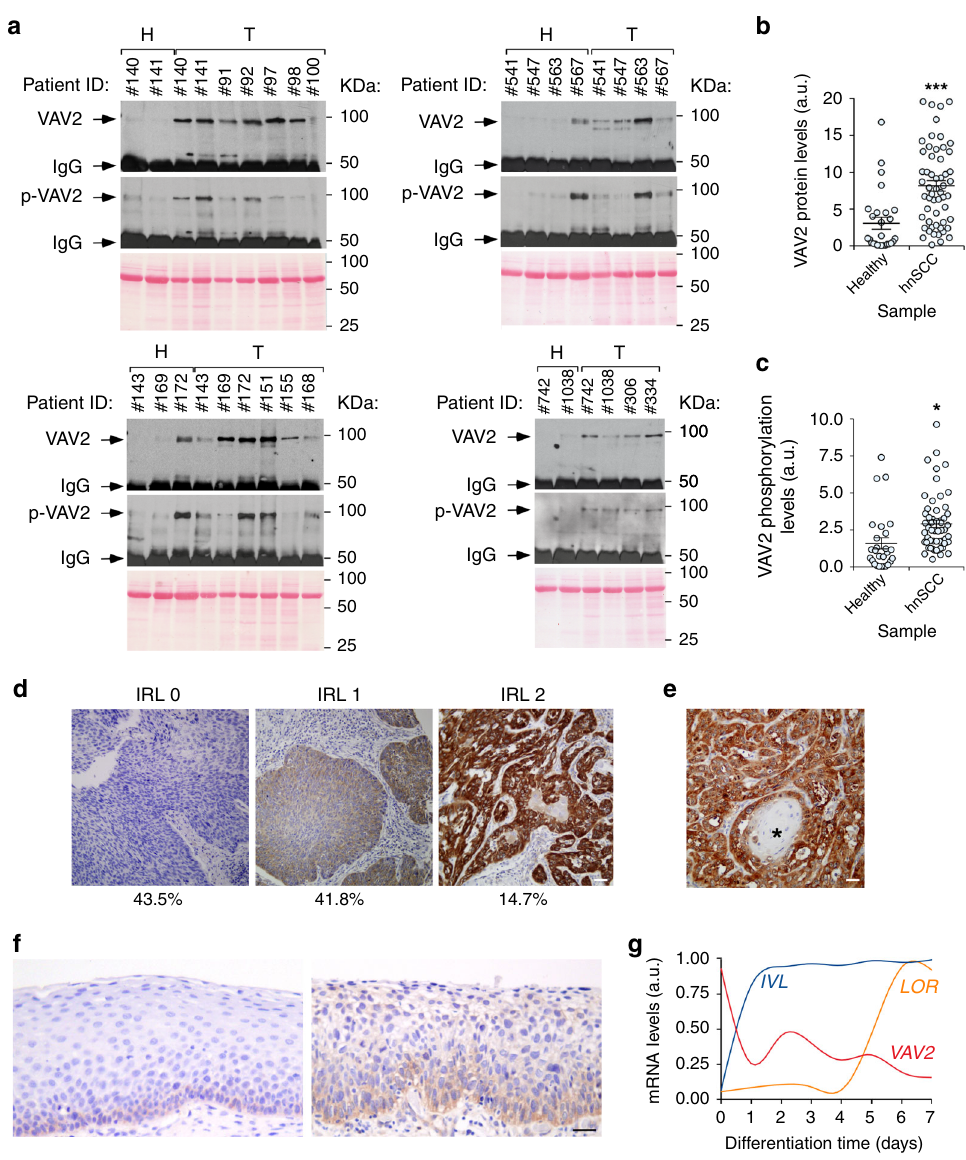
Fig. 2 VAV2 protein is overexpressed in hnSCC. a Levels of total (VAV2) and tyrosine-phosphorylated (p-VAV2) VAV2 in healthy (H) and tumor (T) tissues from hnSCC patients ( n = 83). The band corresponding to the antibody used for the immunoprecipitation step is indicated (IgG). Amount of total protein content in the extracts used for the immunoprecipitation was tested in parallel fi lters using Ponceau staining (bottom panels). KDa, kilodalton. b VAV2 abundance according to data from a . *** P < 0.0001 (two-tailed Mann – Whitney test, n = 83 patient samples). a.u., arbitrary units. c VAV2 tyrosine phosphorylation levels according to data obtained in a . * P = 0.011 (two-tailed Mann – Whitney test, n = 83 patient samples). Please, note that the total levels of tyrosine phosphorylation of VAV2 in these analyses are probably underestimated given the long experimental procedure associated with tumor collection and subsequent lysis. d Example of tumor sections showing the indicated VAV2 immunoreactivity levels (IRL, top). The percentages of tumor samples (% out of a total of 232 tumors analyzed) showing the indicated VAV2 immunoreactivity levels are shown at the bottom. n = 232 tumor samples. Scale bar, 200 μ m. e Representative image showing the lack of VAV2 immunoreactivity in terminally differentiated areas (asterisk) of VAV2-positive tumors. Scale bar, 100 μ m. f Representative images of the immunohistochemical staining of VAV2 in healthy (left) and dysplastic (right) samples from human oral epithelium. Sections were counterstained with hematoxylin. n = 232 tumor samples. Scale bar, 100 μ m. g Expression levels of the indicated transcripts according to the differentiation status of keratinocytes. Data were obtained from the GEO GSE52651 dataset (see “ Methods ” ). IVL involucrin (an mRNA expressed from the early stages of keratinocyte terminal differentiation); LOR loricrin (a transcript encoding a major protein component of the corni fi ed cell envelope that is found in terminally differentiated epidermal cells). In b and c , data represent the mean ± SEM. Source data for this fi gure are provided as a Source Data fi layers of the normal oral epithelium obtained from the same the foregoing cases were lower than those detected in tumors patients (Fig. 2f, left panel). However, we found that the VAV2 (Fig. 2d, e). The preferential expression of the VAV2 mRNA in immunoreactivity expands to suprabasal cell layers when keratinocyte precursors and its downmodulation in more mature analyzed in samples exhibiting histological signs of dysplasia derivatives is also observed in the skin when using gene (Fig. 2f, right panel). The levels of immunoreactivity found in expression data from organotypic cultures that recapitulate this